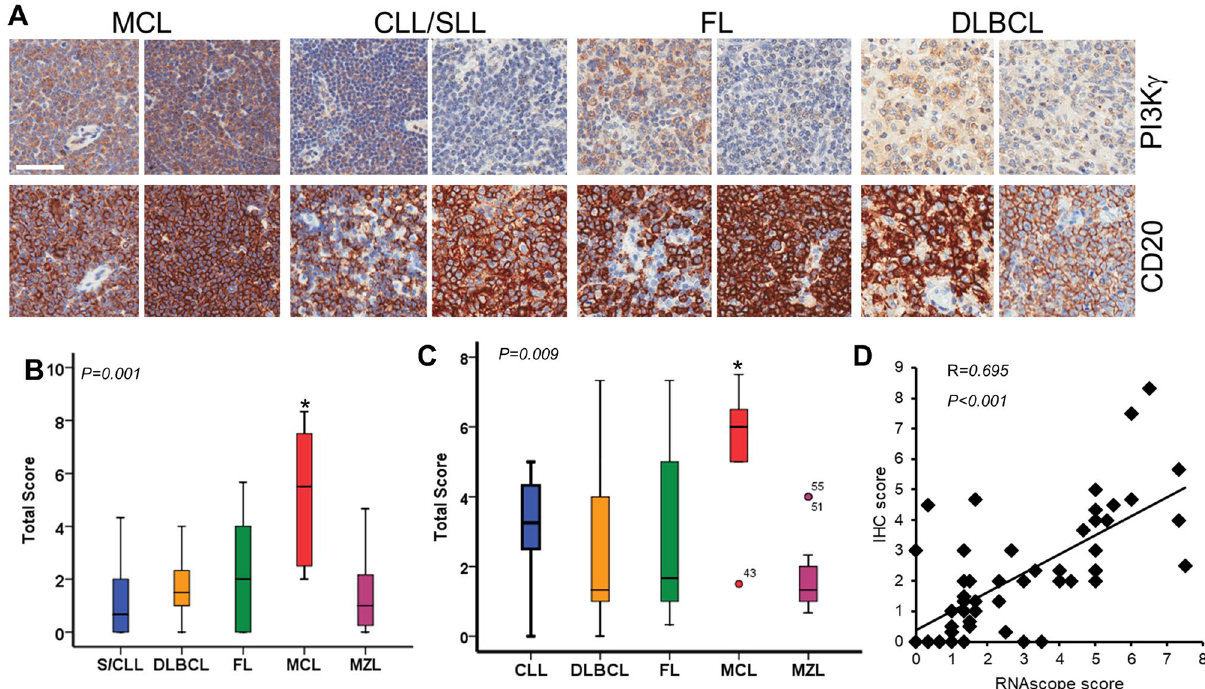
Figure 1. Expression of PI3Kγ within B-NHL in tissues. TMAs were analysed for PI3Kγ expression by IHC and RNAscope using DAB (brown) as the chromogenic substrate; the counter stain was haematoxylin (blue). ( A ) Representative examples of TMA staining for PI3Kγ protein ( upper ) and CD20 ( lower ) on adjacent LN sections taken from patients with MCL, CLL/SLL, FL and DLBCL. For MCL different patterns of positive staining are shown. Whereas, for CLL/SLL, FL and DLBCL the left-hand panel shows cores with high levels of PI3Kγ and the right-hand panel cores with lower levels of staining. Bar = 50 μM. ( B ) Comparison of IHC staining scores. ( C ) Comparison of PI3Kγ mRNA in a serial section of the same TMA measured using RNAScope. * P < 0.05. Statistical significance was determined using the Mann-Witney U-test. ( D ) Correlation, using Pearson’s coefficient, between PI3Kγ protein and mRNA expression as determined by IHC and RNAScope